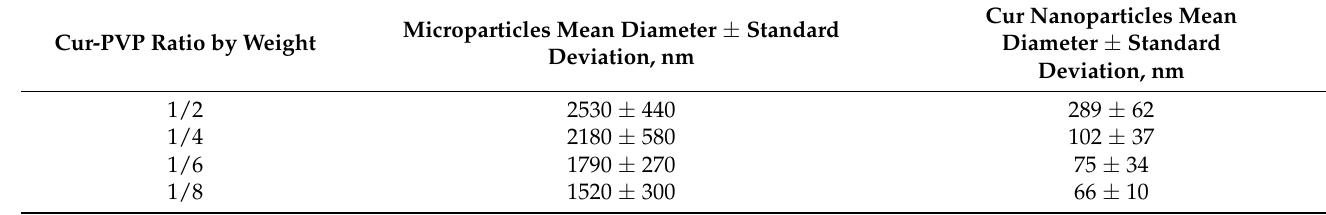
Table 1. Mean diameters measured by DLS of Cur-PVP microparticles and curcumin nanoparticles, tested in this work.